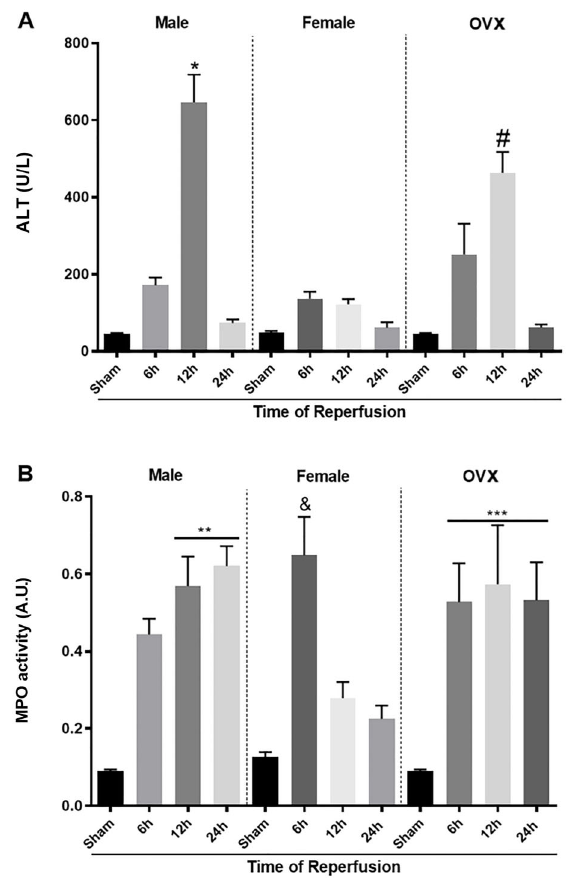
Figure 2. Parameters of liver injury and in fl ammation were evaluated at different times after reperfusion in male, female, and ovariectomized (OVX) mice. The ischemia and reperfusion induced a signi fi cant increase in aminotransferase (ALT) in serum and myeloperoxidase (MPO) activity in the liver of male mice ( A and B ). Female mice showed lower ALT in the serum and MPO activity after 12 h of reperfusion. OVX Females showed increased ALT levels and MPO activity compared with non-ovariectomized mice ( A and B ). Data are reported as means ± SE. *P o 0.05 vs female 12 h; # P o 0.05 vs female 12 h, **P o 0.05 vs female 12 and 24 h; ***P o 0.05 vs female 12 and 24 h. & P o 0.05 vs female sham (ANOVA). A.U.: arbitrary